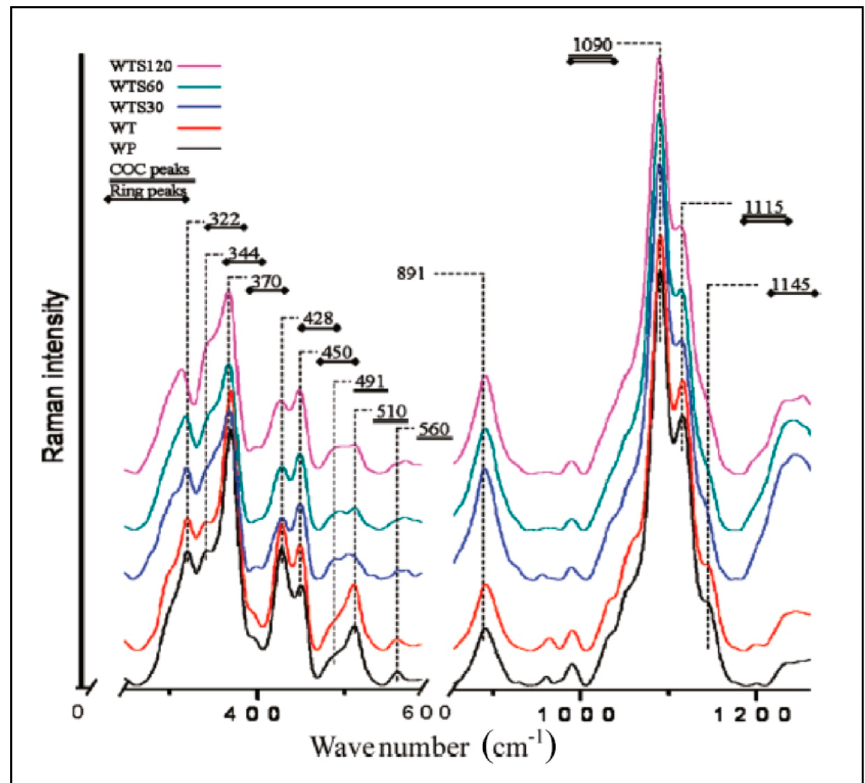
Figure 4. Raman spectra of molecularly thin (single digit angstrom thickness) cellulose nanoparticles that were obtained by intensive sonication of TEMPO-oxidized cellulose fibers. Spectra of TEMPO treated (WT) and control wood pulp (WP) are also shown. Reproduced with permission from Ref. [30]. Copyright American Chemical Society